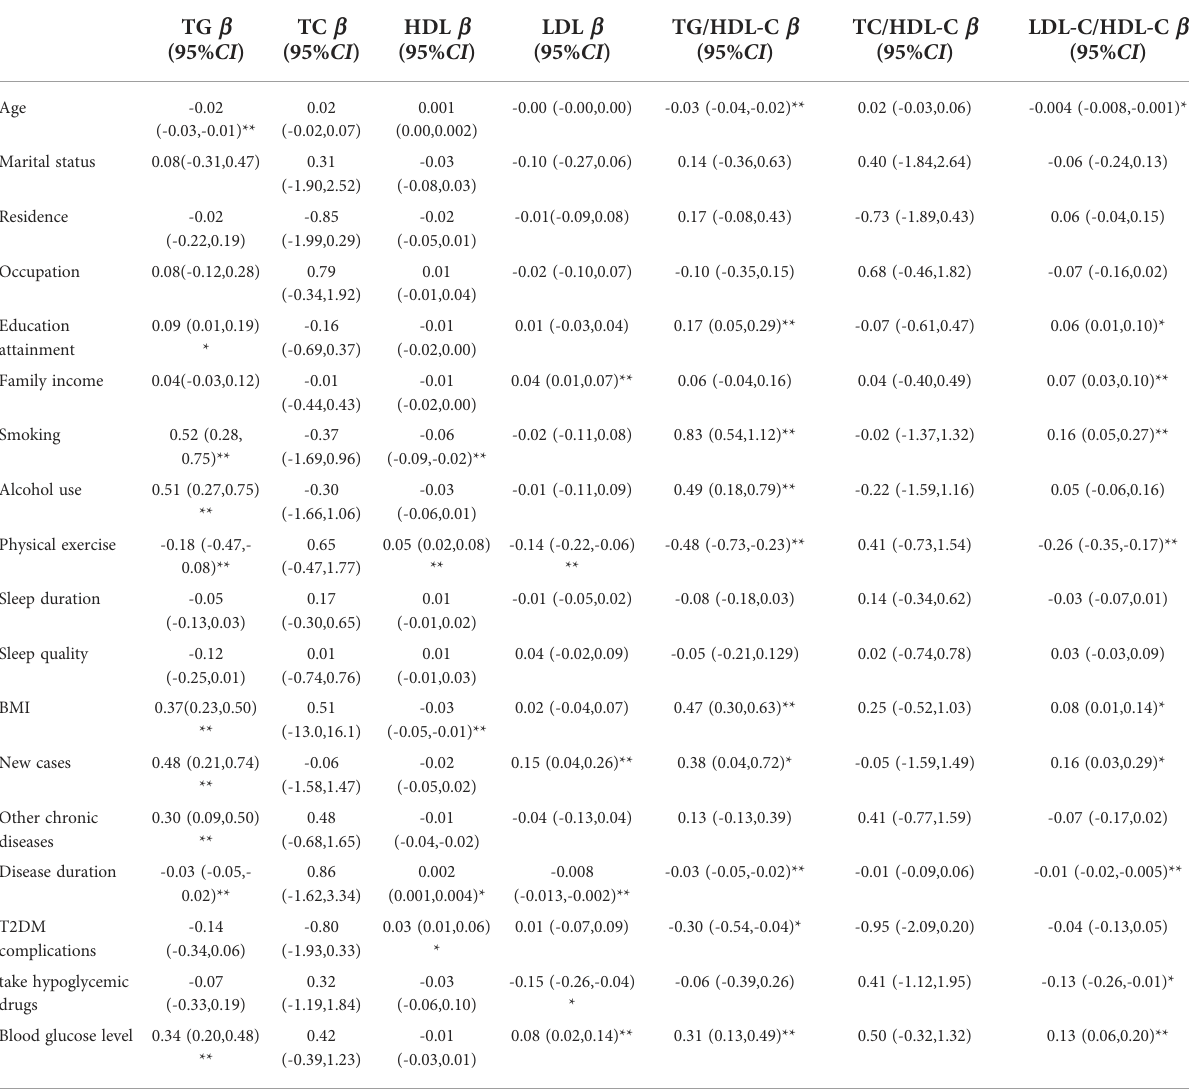
TABLE 2 Binary regression